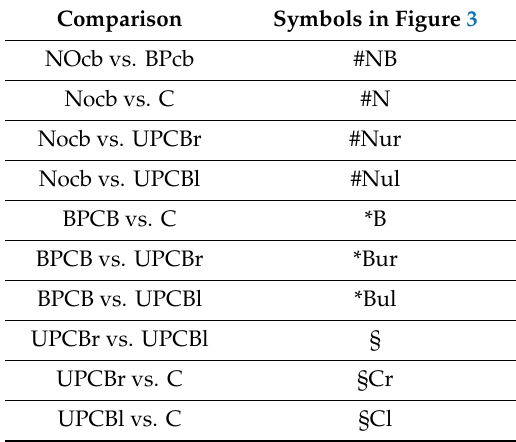
Table 2. symbols legend of one-way ANOVA significant